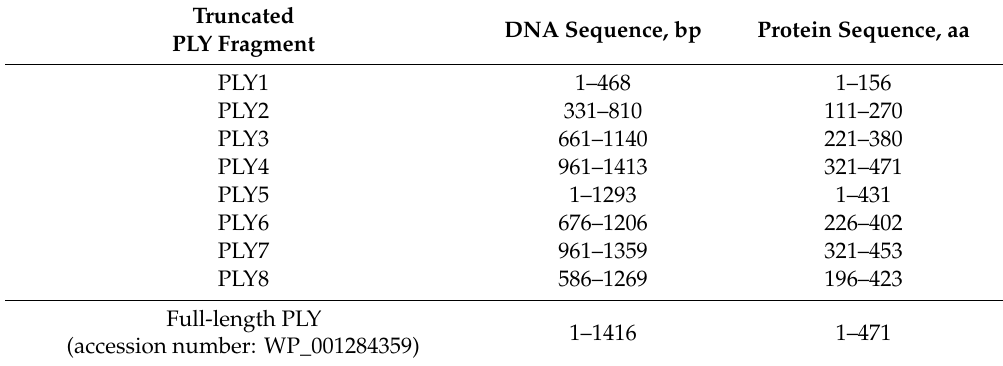
Table 1. The list of truncated pneumolysin (PLY) fragments: their DNA (bp) and amino acids (aa) sequences.